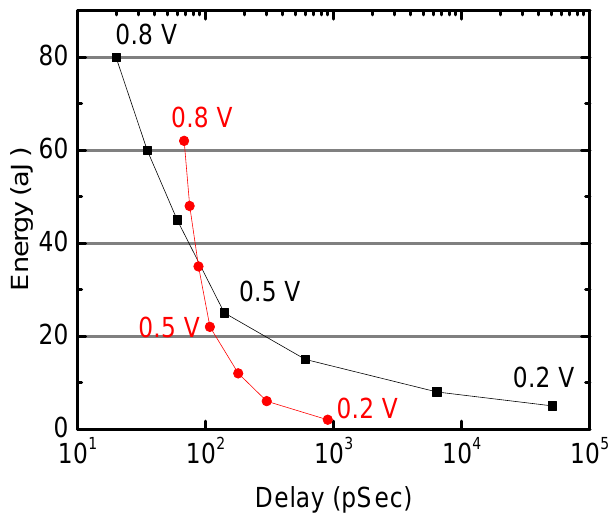
Figure 22. Energy versus delay for CMOS (squares) and TFET (circles) logic gates ‐ AND